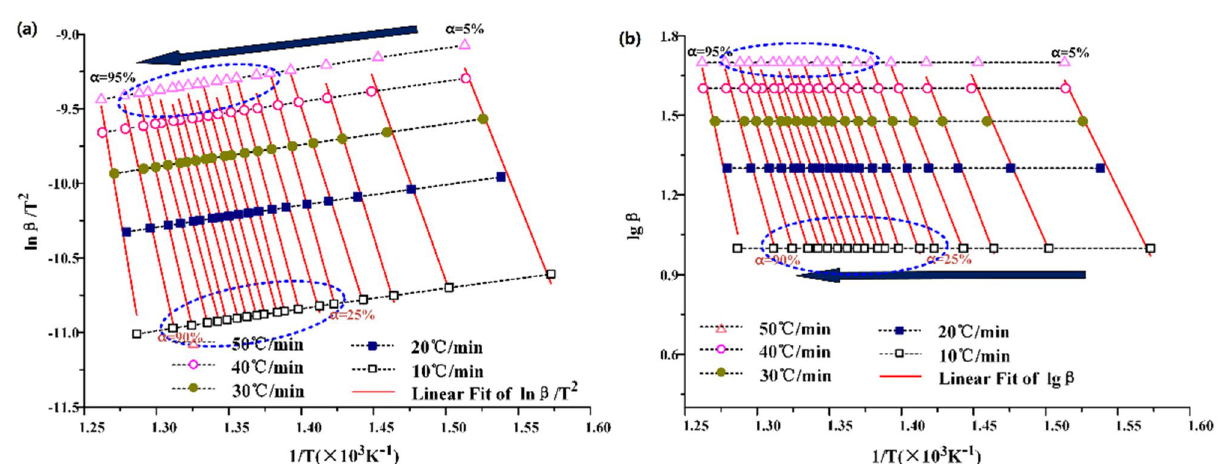
Figure 5. Calculating curve of activation energy under N 2 .